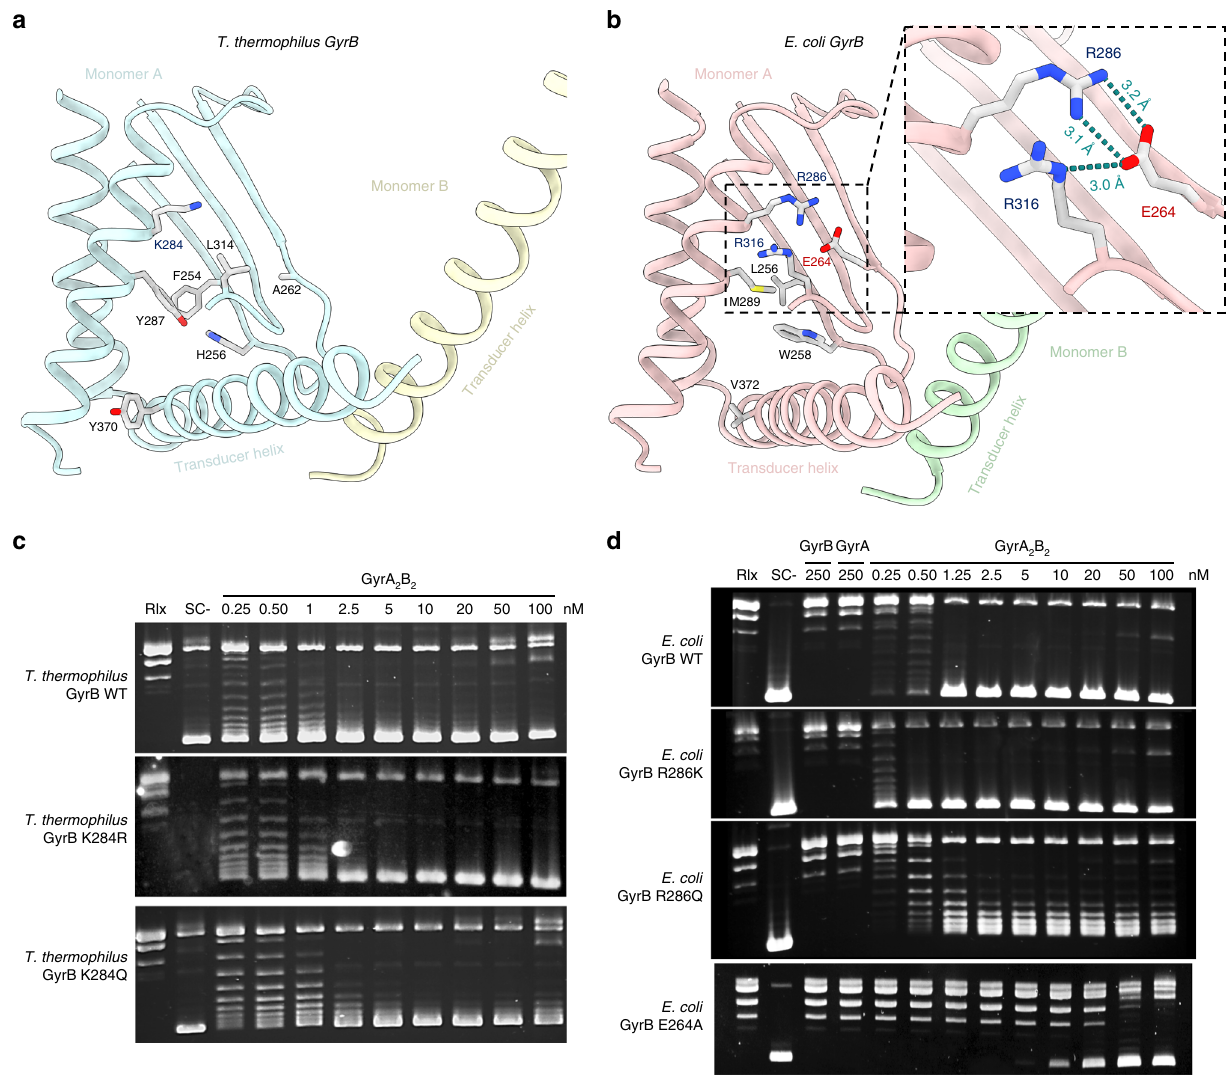
Fig. 4 Transducer structural elements involved in allosteric regulation. a Cartoon representation of the T . thermophilus GyrB transducer domain. The K284 residue is not engaged in an interaction network. The transducer is mainly stabilized by a hydrophobic core (only side chains different in the two species are displayed) and a hydrogen bond involving H256 and Y287. b Cartoon representation of the E . coli GyrB transducer domain. The transducer domain is stabilized by a salt bridge involving R286 and E264 in interaction with R316, anchoring the beta-sheets to the alpha helix. c DNA negative supercoiling activities of wild-type, K284R and K284Q T . thermophilus DNA gyrase showing no effect of the mutations. Protein concentrations are indicated in nM holoenzyme. Negative and positive controls are shown as relaxed (Rlx) or negatively supercoiled DNA species (SC − ), respectively. d DNA negative supercoiling activity of wild-type, R286K, R286Q, and E264A E . coli DNA gyrase showing no effect of R286K but an impaired activity of the R286Q and E264A mutants. The source data are provided as a Source Data fi